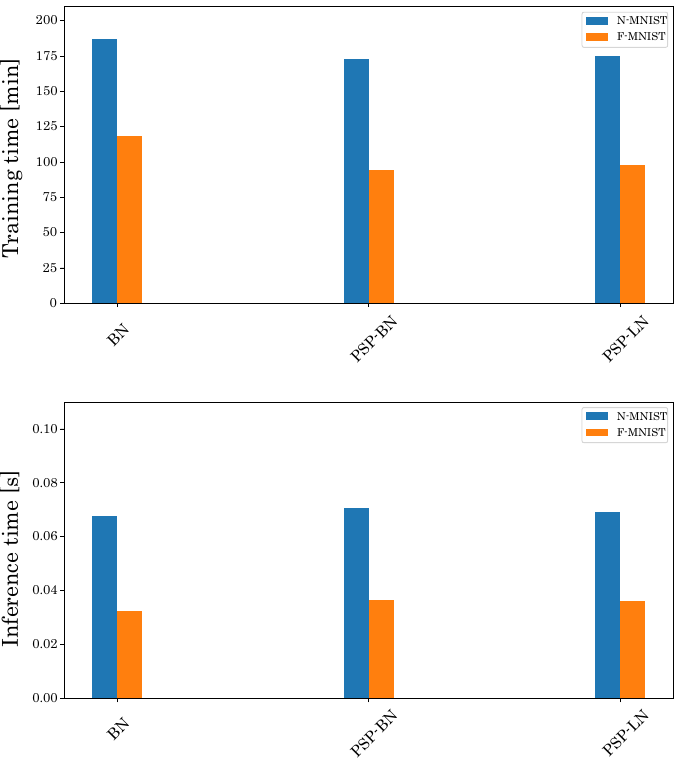
Figure 10. Comparison of the training and inference time by using BN, PSP-BN and PSP-LN. The top is the training time and the bottom is the inference time.